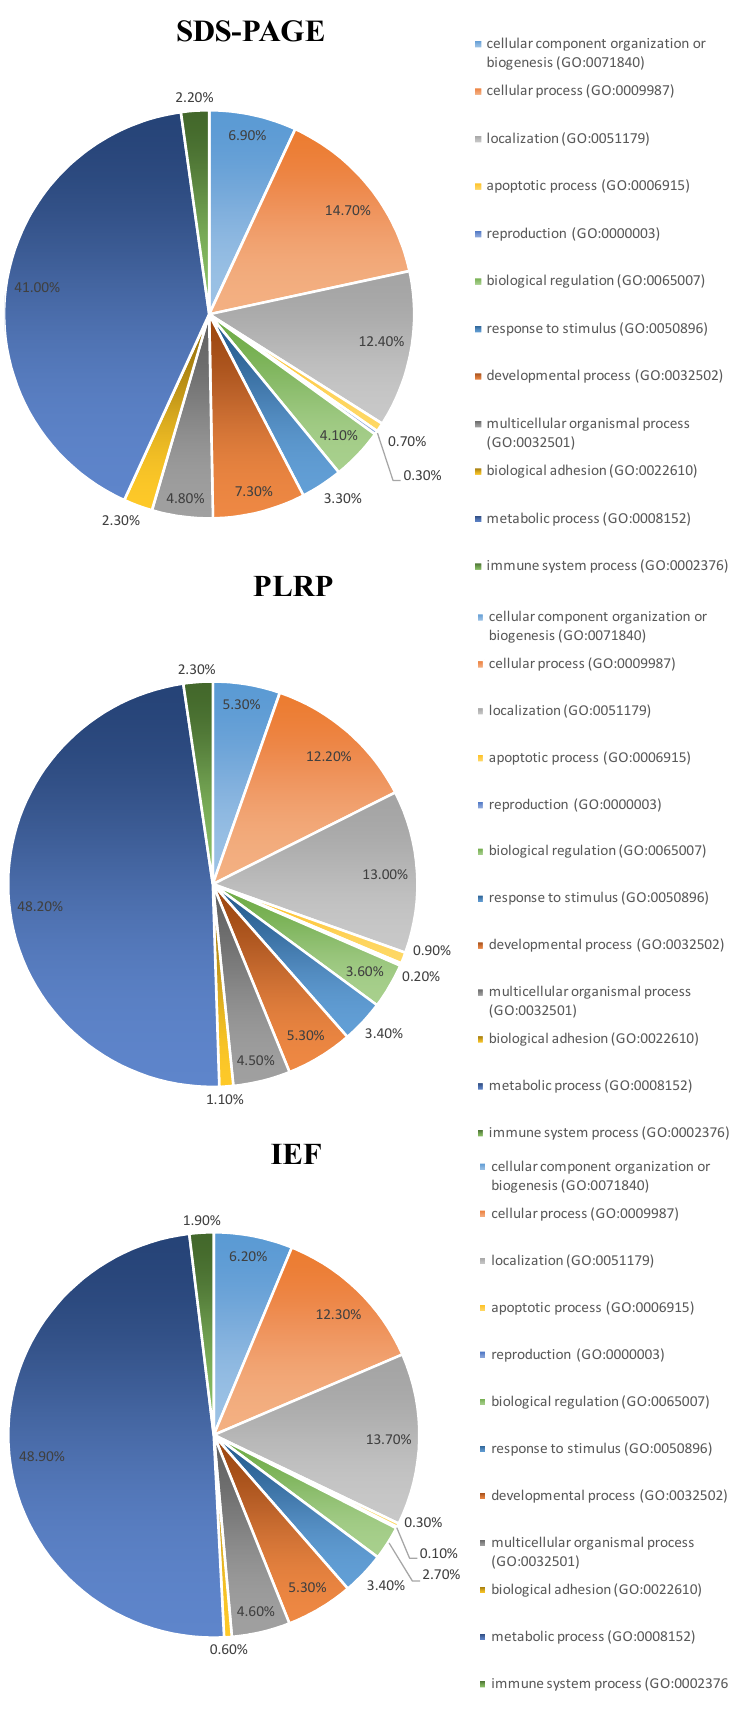
Figure 6. Gene ontology categorization of the identified proteins according to biological